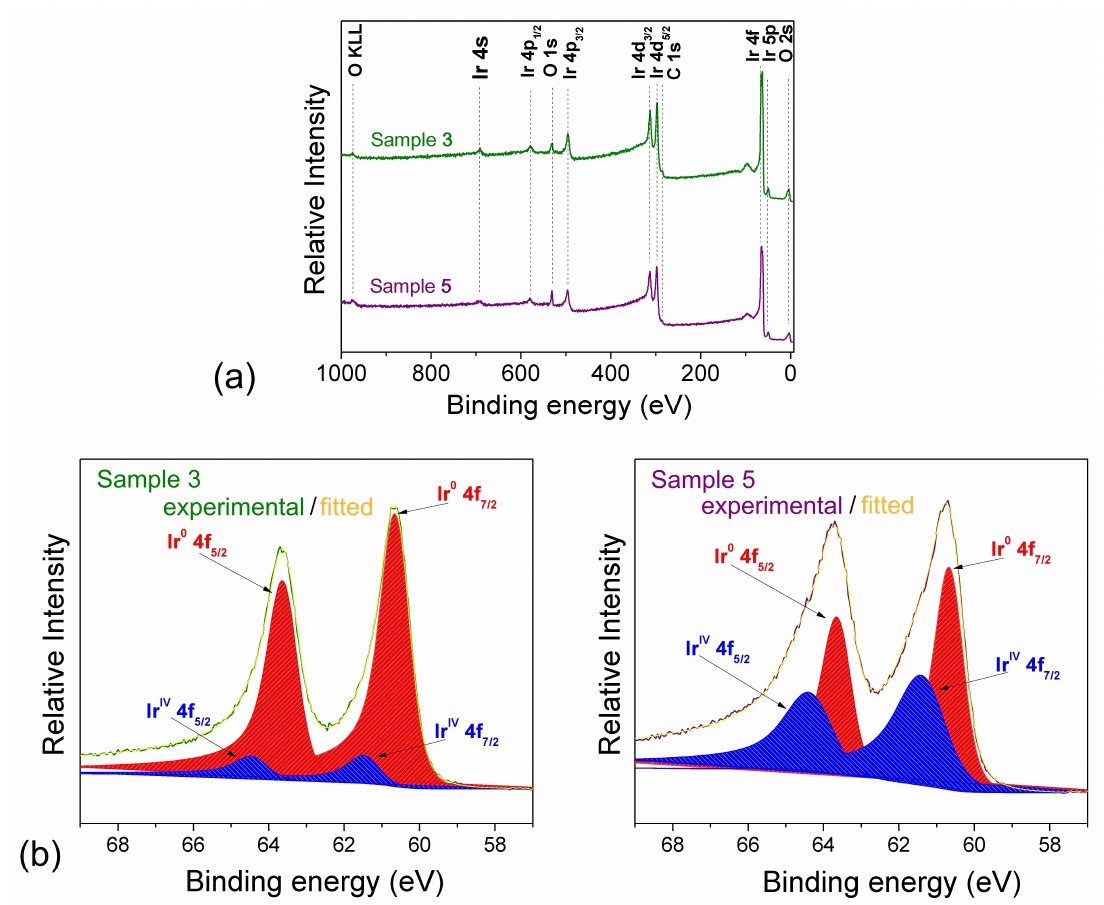
Figure 3. XPS spectra of the iridium coatings on Si(100) after etching with Ar + ( a ); fitting of Ir 4f spectra into the Ir 0 and Ir IV components ( b